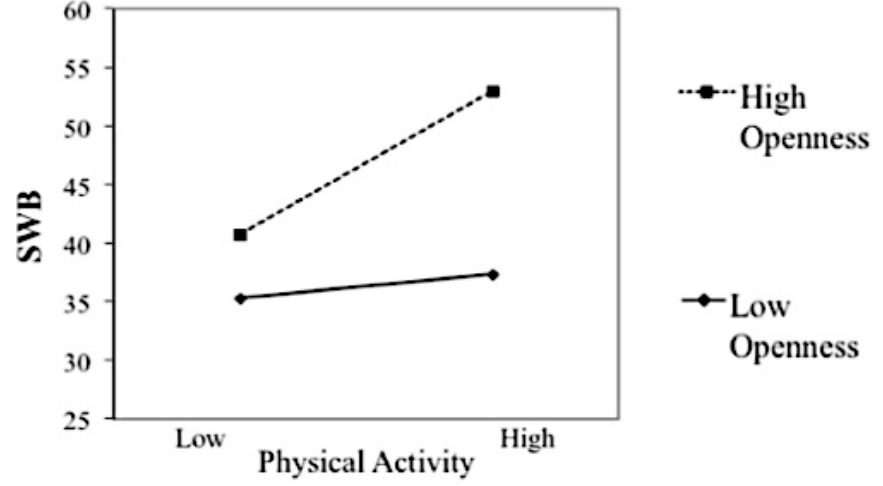
Figure 2. Openness to experience’s moderation of the relationship between physical activity and SWB.